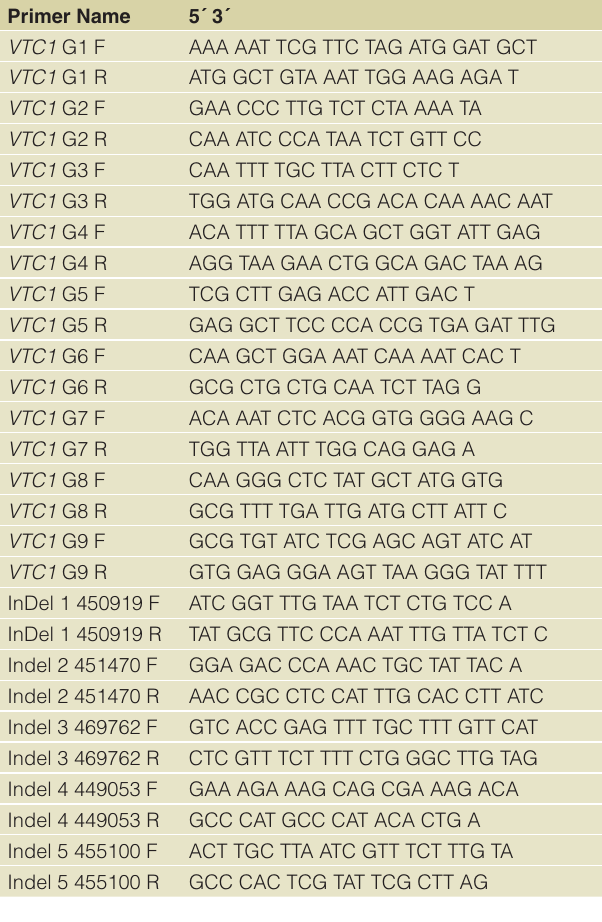
Table 1. Forward (F) and reverse (R) sequences of primers used in analyzing the VTC1 gene and for amplifying five Col/L er Insertion/Deletion (InDel)